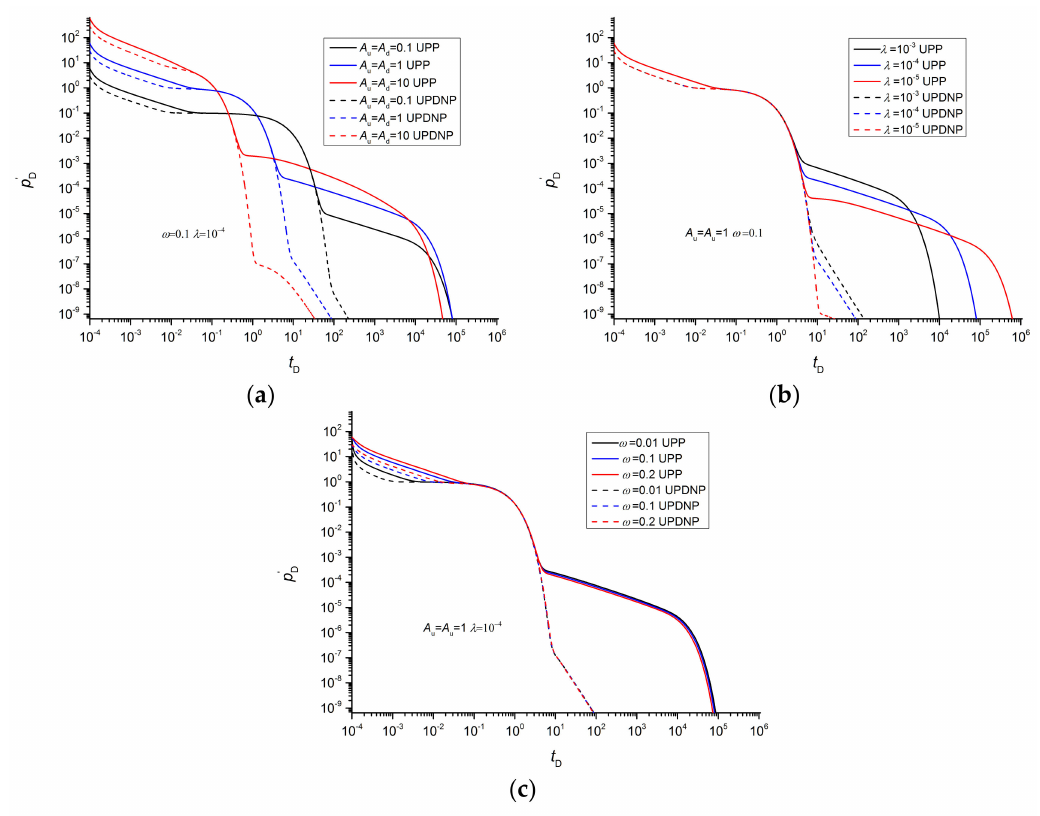
Figure 7. Comparison of pressure derivative curves between the UPP method and UPDNP